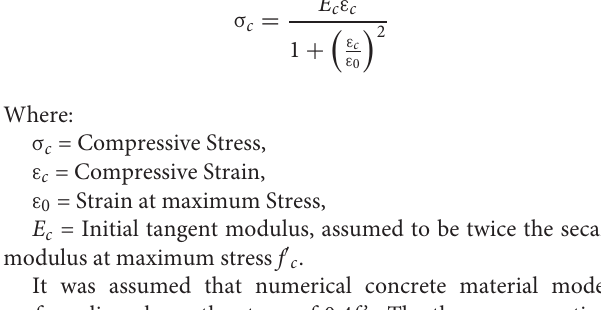
Frontiers in Built Environment |